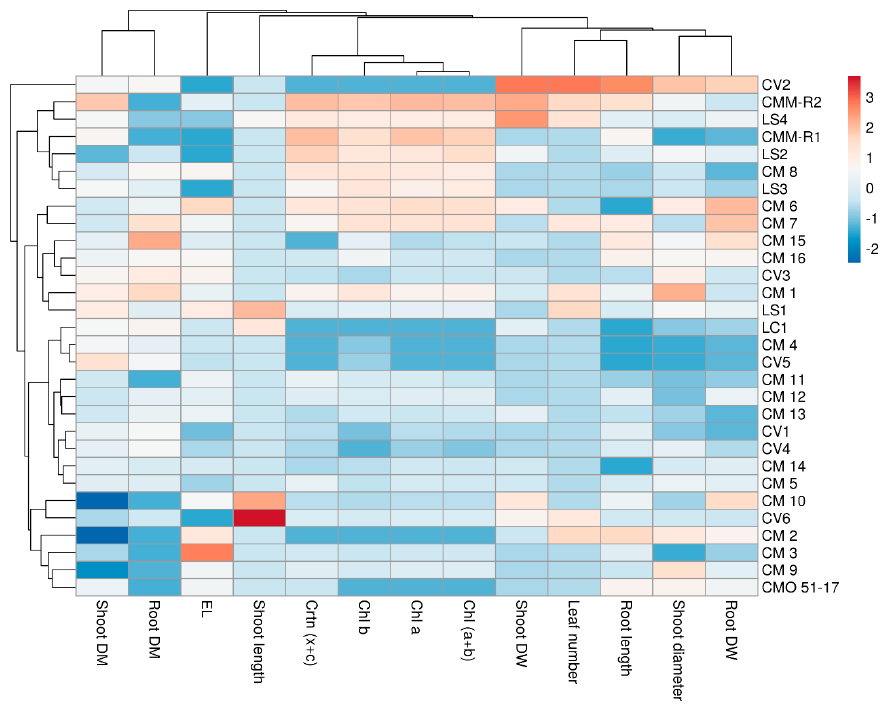
Figure 5. Cluster heat map analysis of the percentage variation to the increase of NaCl level of all the analyzed parameters in seedlings of sixteen Cucumis melo L, six Citrullus vulgaris Schrad., two C. maxima × C. moschata , four Lagenaria siceraria (Molina) Standl. di ff erent genotypes, and Cucurbita moschata Duch. cv 51–17 and Lu ff a cylindrica Mill. grown in a floating system in a nursery greenhouse. It was generated using the ClustVis online software [18] with Euclidean distance as the similarity measure and hierarchical clustering with complete